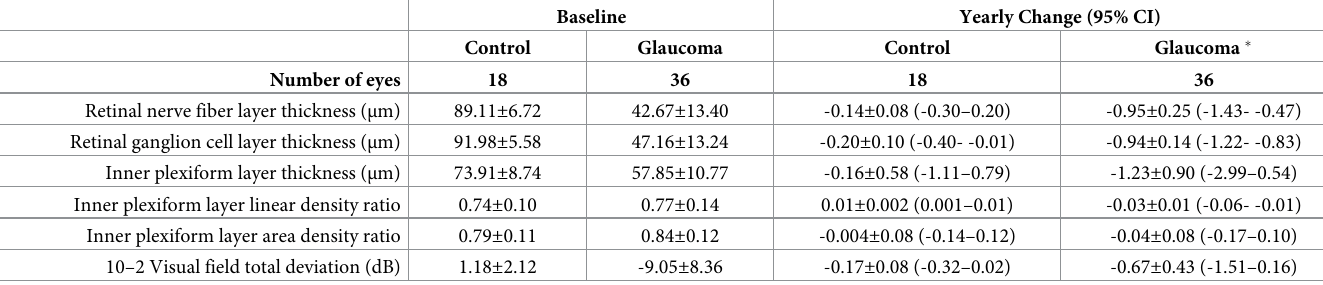
Table 2. Summary of the data from sequential analysis of macular SD-OCT scans and visual